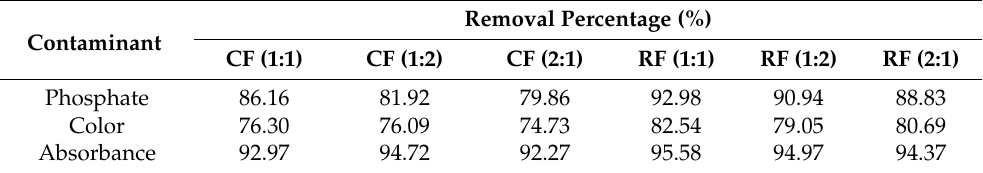
Figure 6. Evaluation of different coagulants on turbidity removal (%). Table 8. Comparison results of different types of